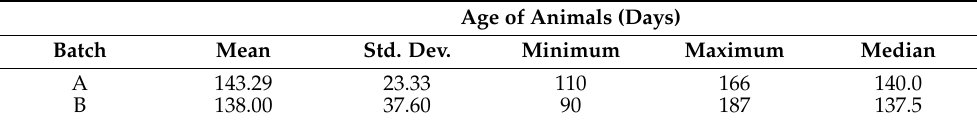
Table 2. Summary of characteristics of viral shedding in feces, by age of animals for 10 and 13 animals of batch A and B, respectively. The age corresponds to the last HEV positivity detected in each batch. The age of pig was considered positive up to the last sampling of HEV-RNA detection.